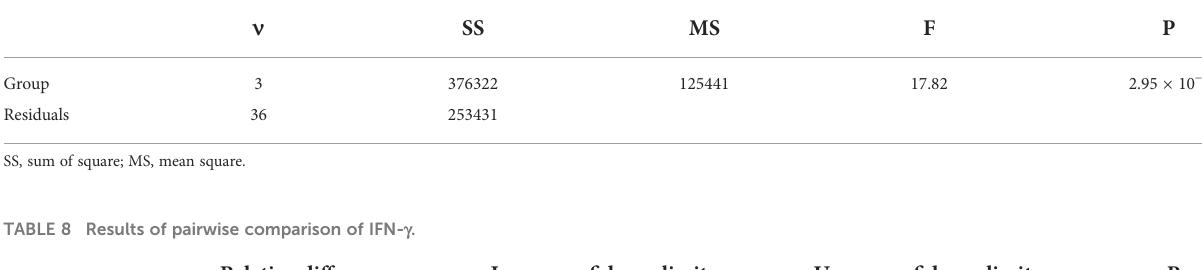
TABLE 7 Results of ANOVA of IFN- g .